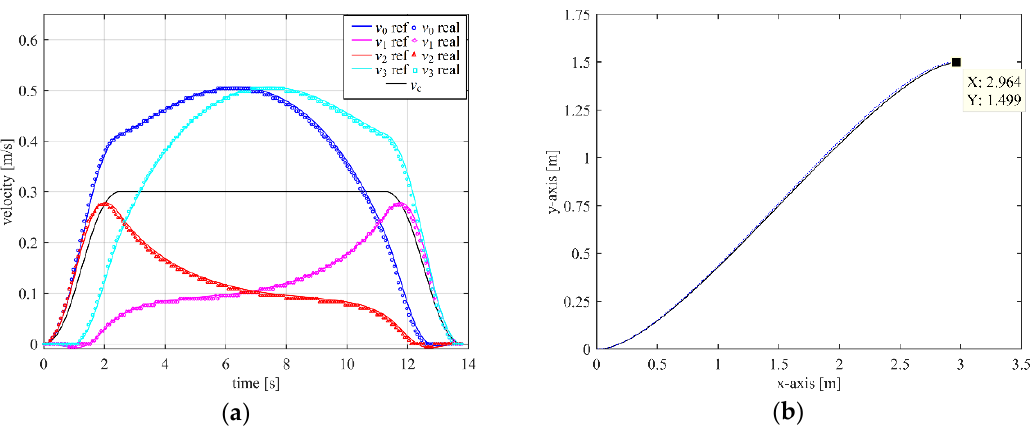
Figure 9. Navigation of the omnidirectional mobile robot: ( a ) Velocity profiles; ( b ) Trajectory.